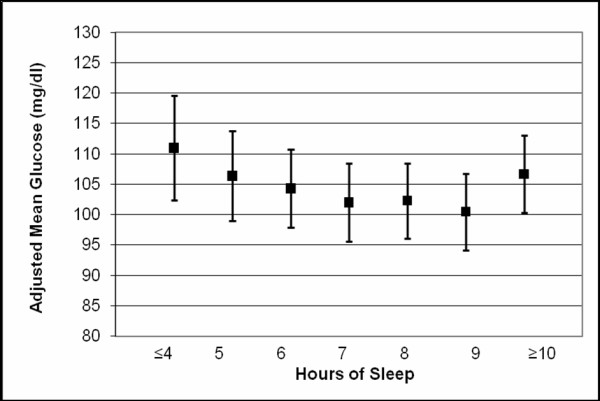
Maternal mean plasma glucose concentrations after a 50-g glucose challenge. Means are adjusted for maternal age and race/ethnicity. Error bars are standard errors.